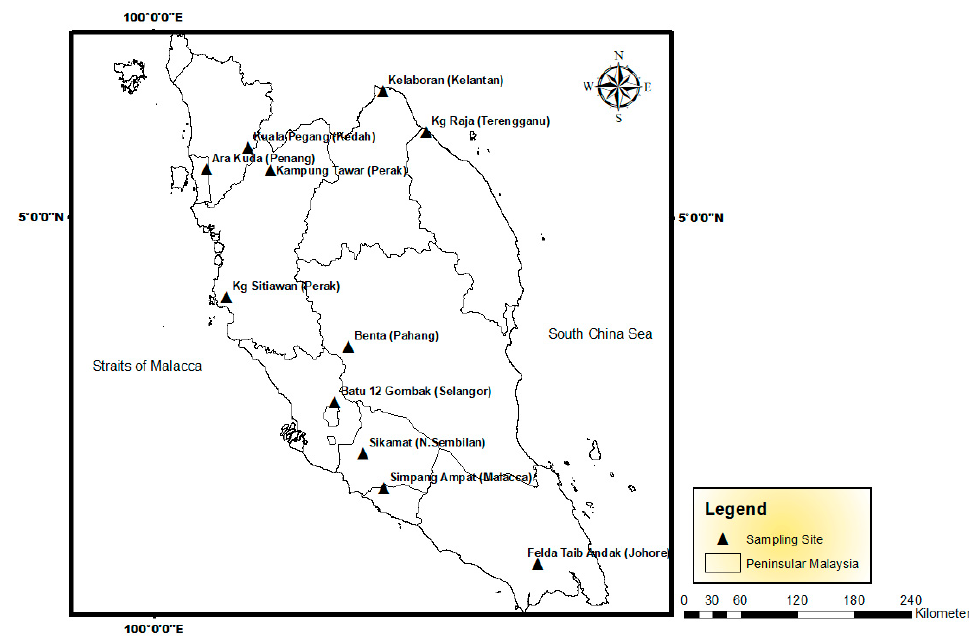
Figure 1. Sampling map for the Amaranthus viridis and their habitat topsoils in Peninsular Malaysia. Table 1. Information on the sampling sites of Amaranthus viridis , and their habitat topsoils from Peninsular Malaysia.